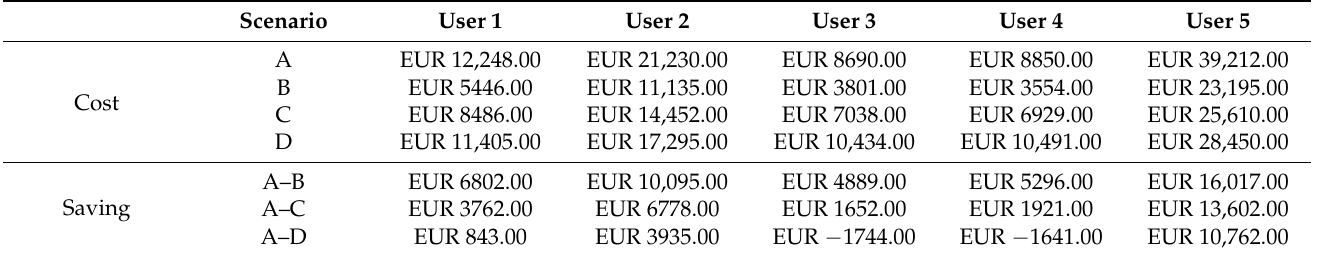
Table 8. Economic results of the 15-year study-case